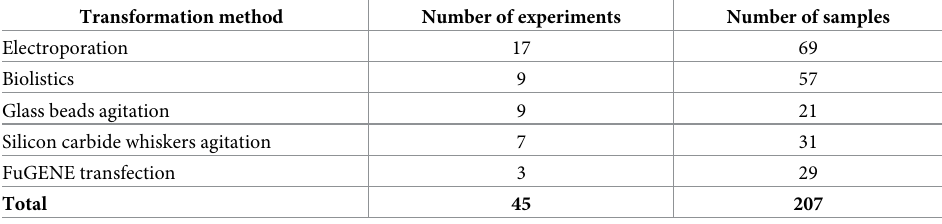
Table 2. Summary list of the number of experiments carried out grouped by transformation method.